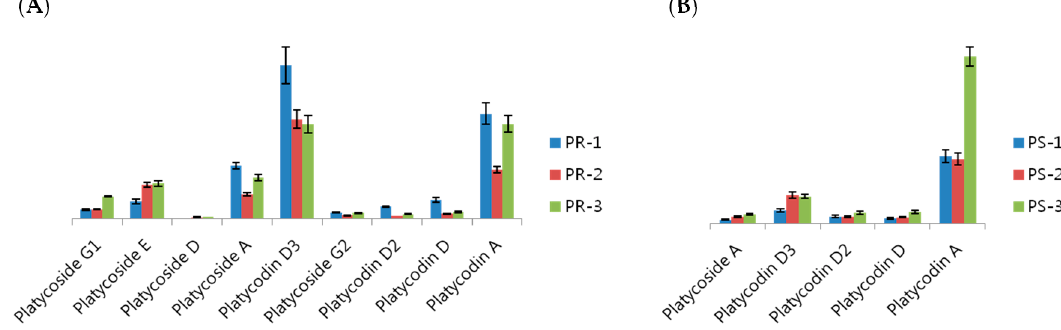
Figure 3. Bar graph of several platycosides in three PRs ( A ) and three PSs ( B